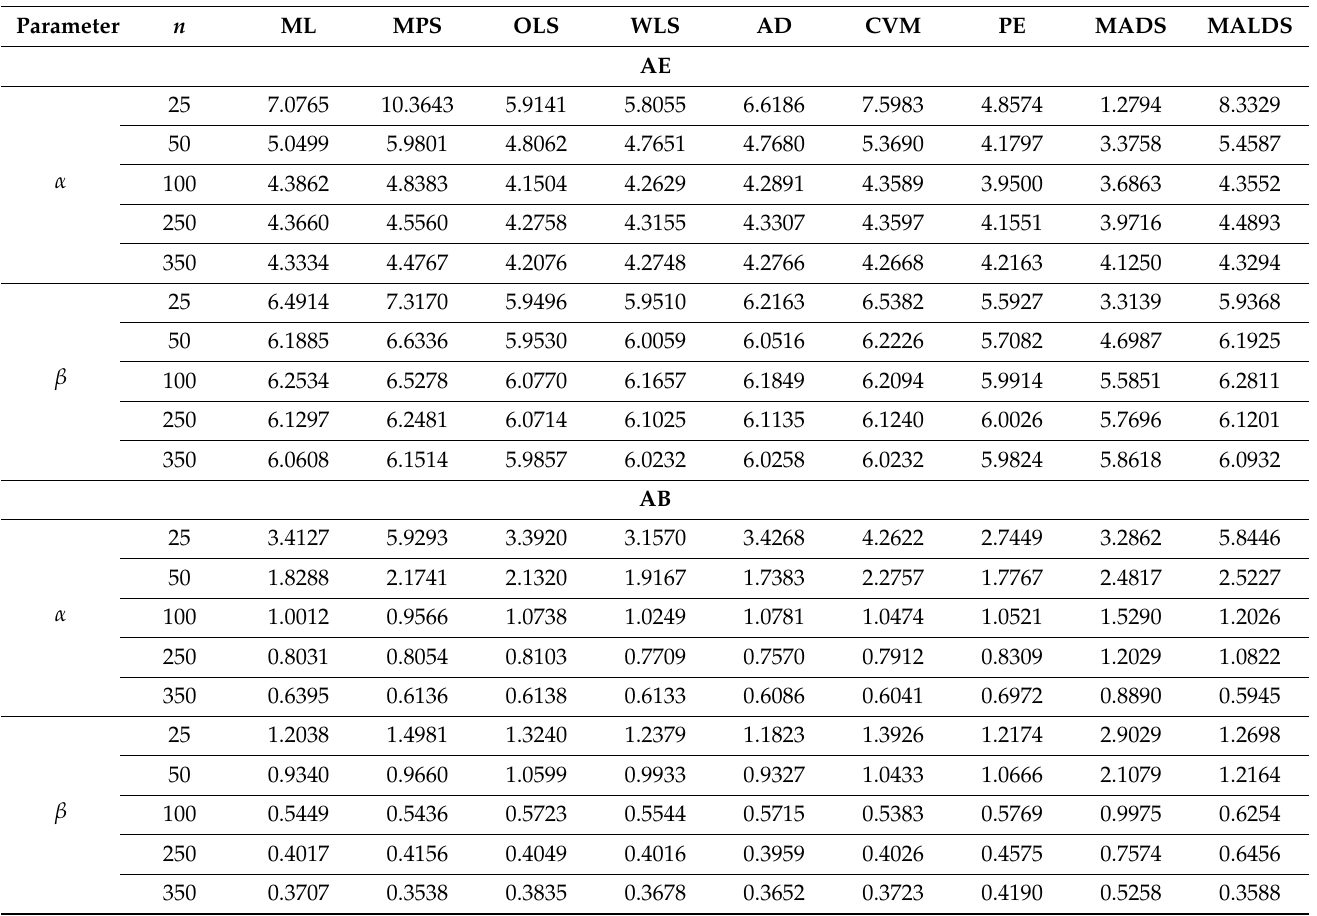
Table 2. AE, AB, and RMSE for α = 4.5 and β =